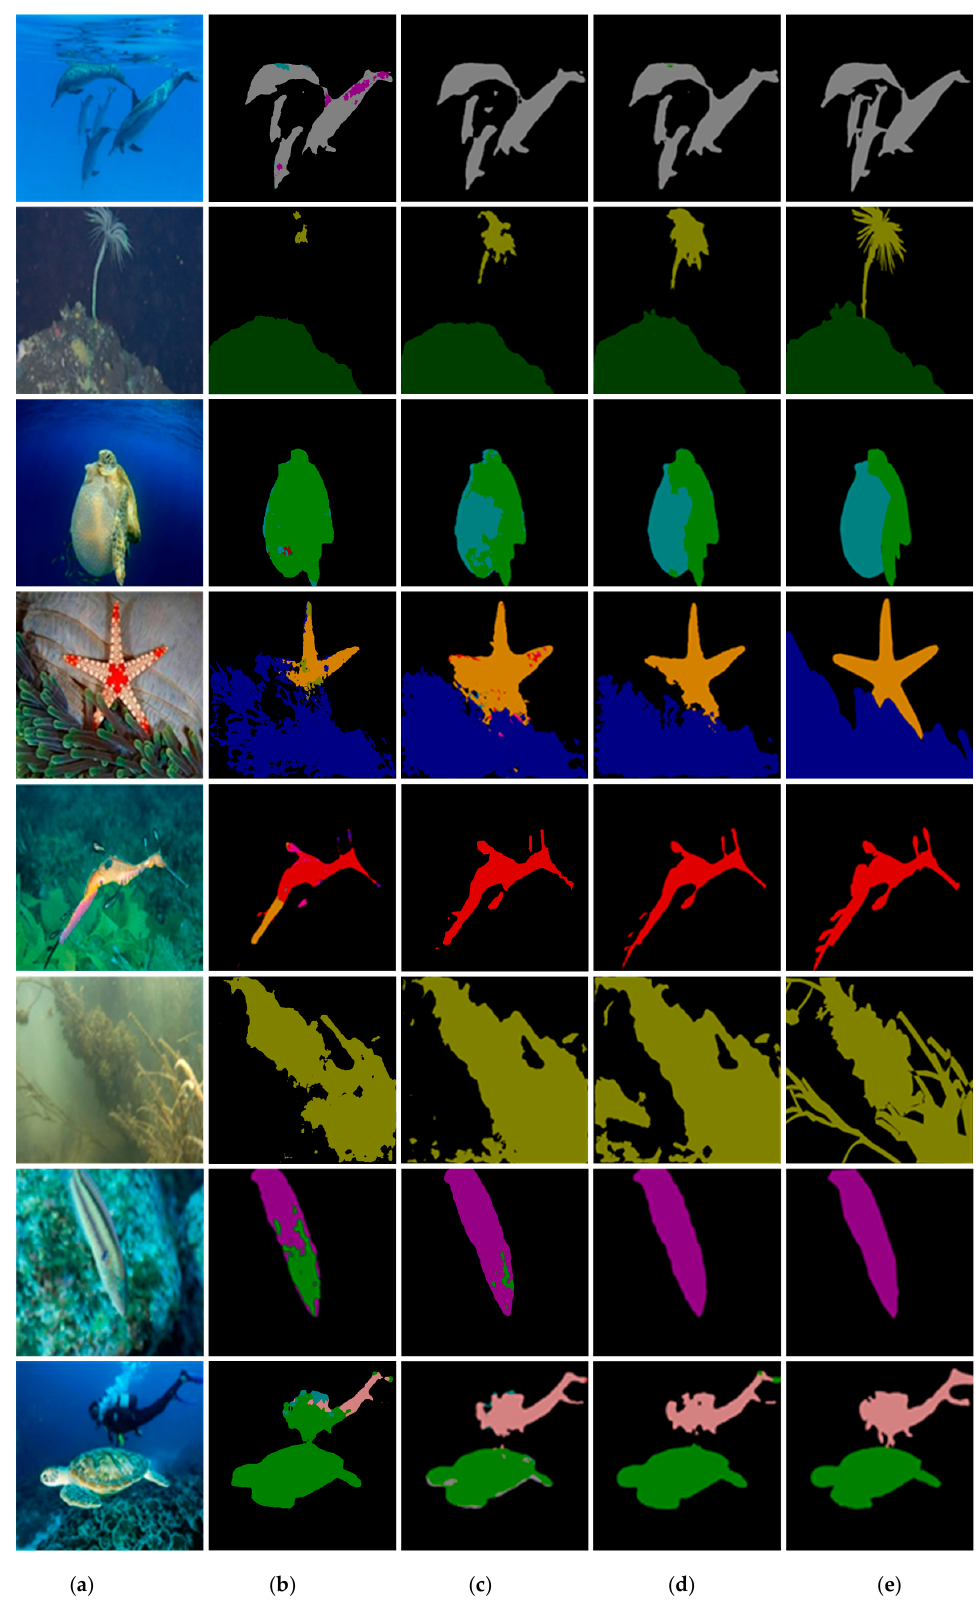
Figure 7. Experimental results and comparison with other methods. ( a ) Original image. ( b ) PSPNet. ( c ) DeepLabv3+. ( d ) Our method. ( e ) Ground truth.